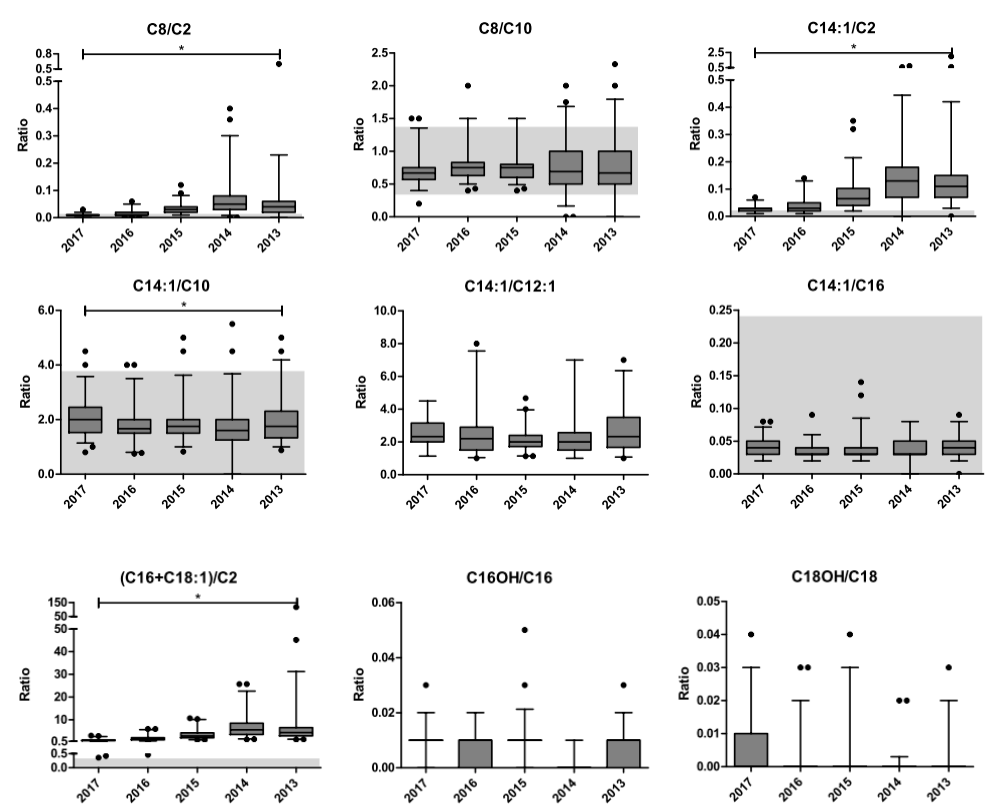
Figure 2. Changes in the molar ratios of carnitine and acylcarnitines. The impact of metabolite instability upon long-term storage at room temperature. The boxplots represent the first quartile, median and third quartile. The whiskers extend to the 2.5th and 97.5th percentiles. Individual dots represent non-extreme outliers. Shaded areas represent the reference ranges as determined by our centre for the neonatal population. For C14:1 / C12:1, no reference range is available because of too many infinite values. For C16OH / C16 and C18OH / C18, the upper reference limit is 0.0. * Statistically significant trend in the molar ratio upon storage duration, as determined by Jonckheere’s trend test. The following ratios were excluded from statistical analysis: C5 / C0-, C14:1 / C12:1-, C16OH / C16-, and C18OH / C18-carnitine. The metabolite instability increases the likelihood of wrong interpretation of acylcarnitine biomarkers for IEMs in DBS stored at room temperature. Tables 1 and 2 present the potential risks for the detection of IEMs upon retrospective MS / MS analysis, and for validation studies in stored control DBS to determine cut-o ff targets for NBS